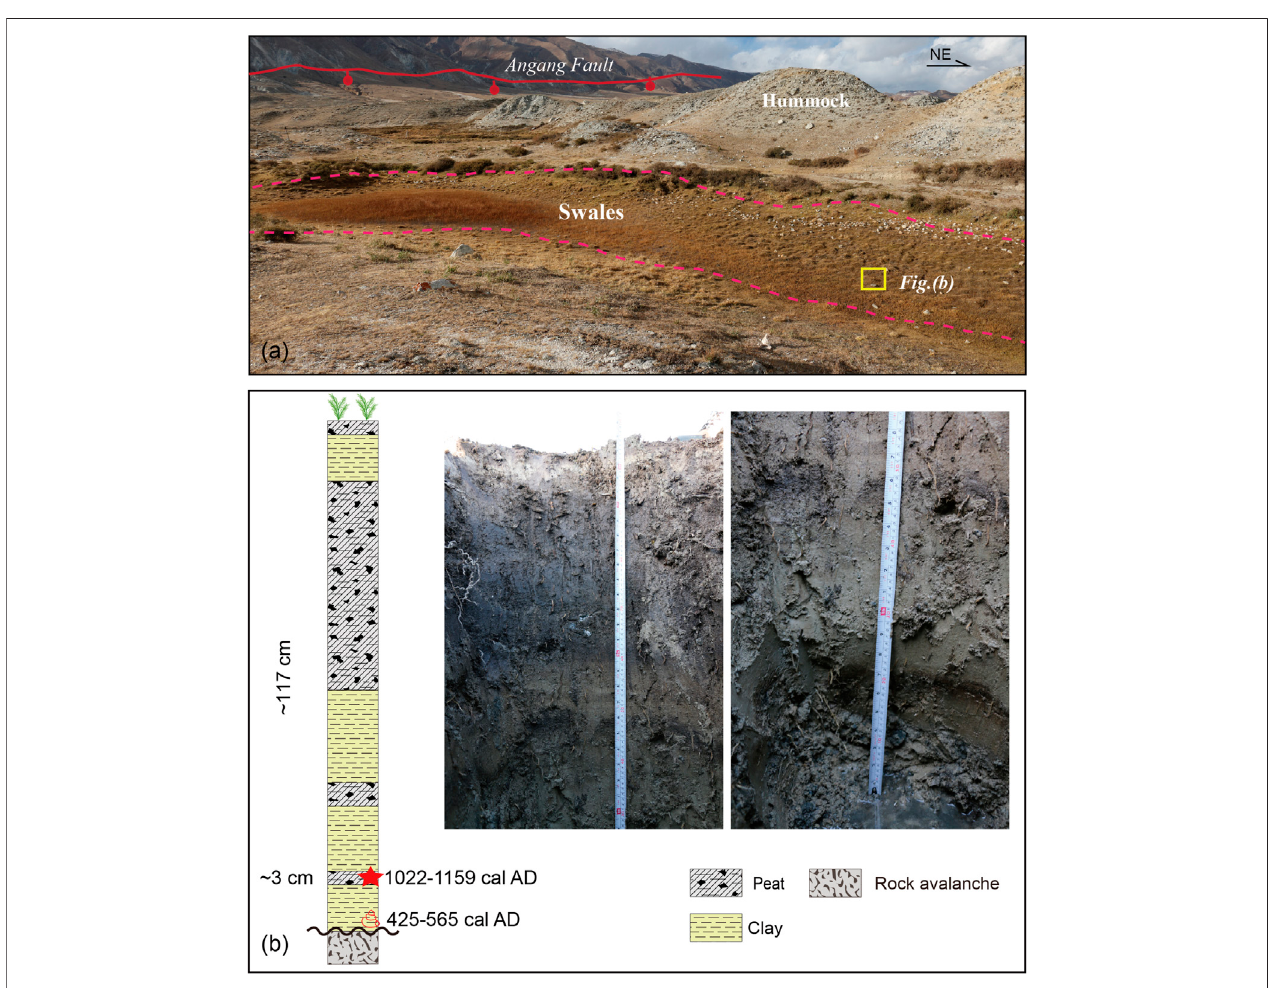
FIGURE 5 | (A) The 14C sample was collected from swales above the NCRA to constrain the minimum age of the fi rst landslide event represented by the NCRA sediment. (B) Snails and plant remnants were sampled for radiocarbon dating in the sediment pro fi le.